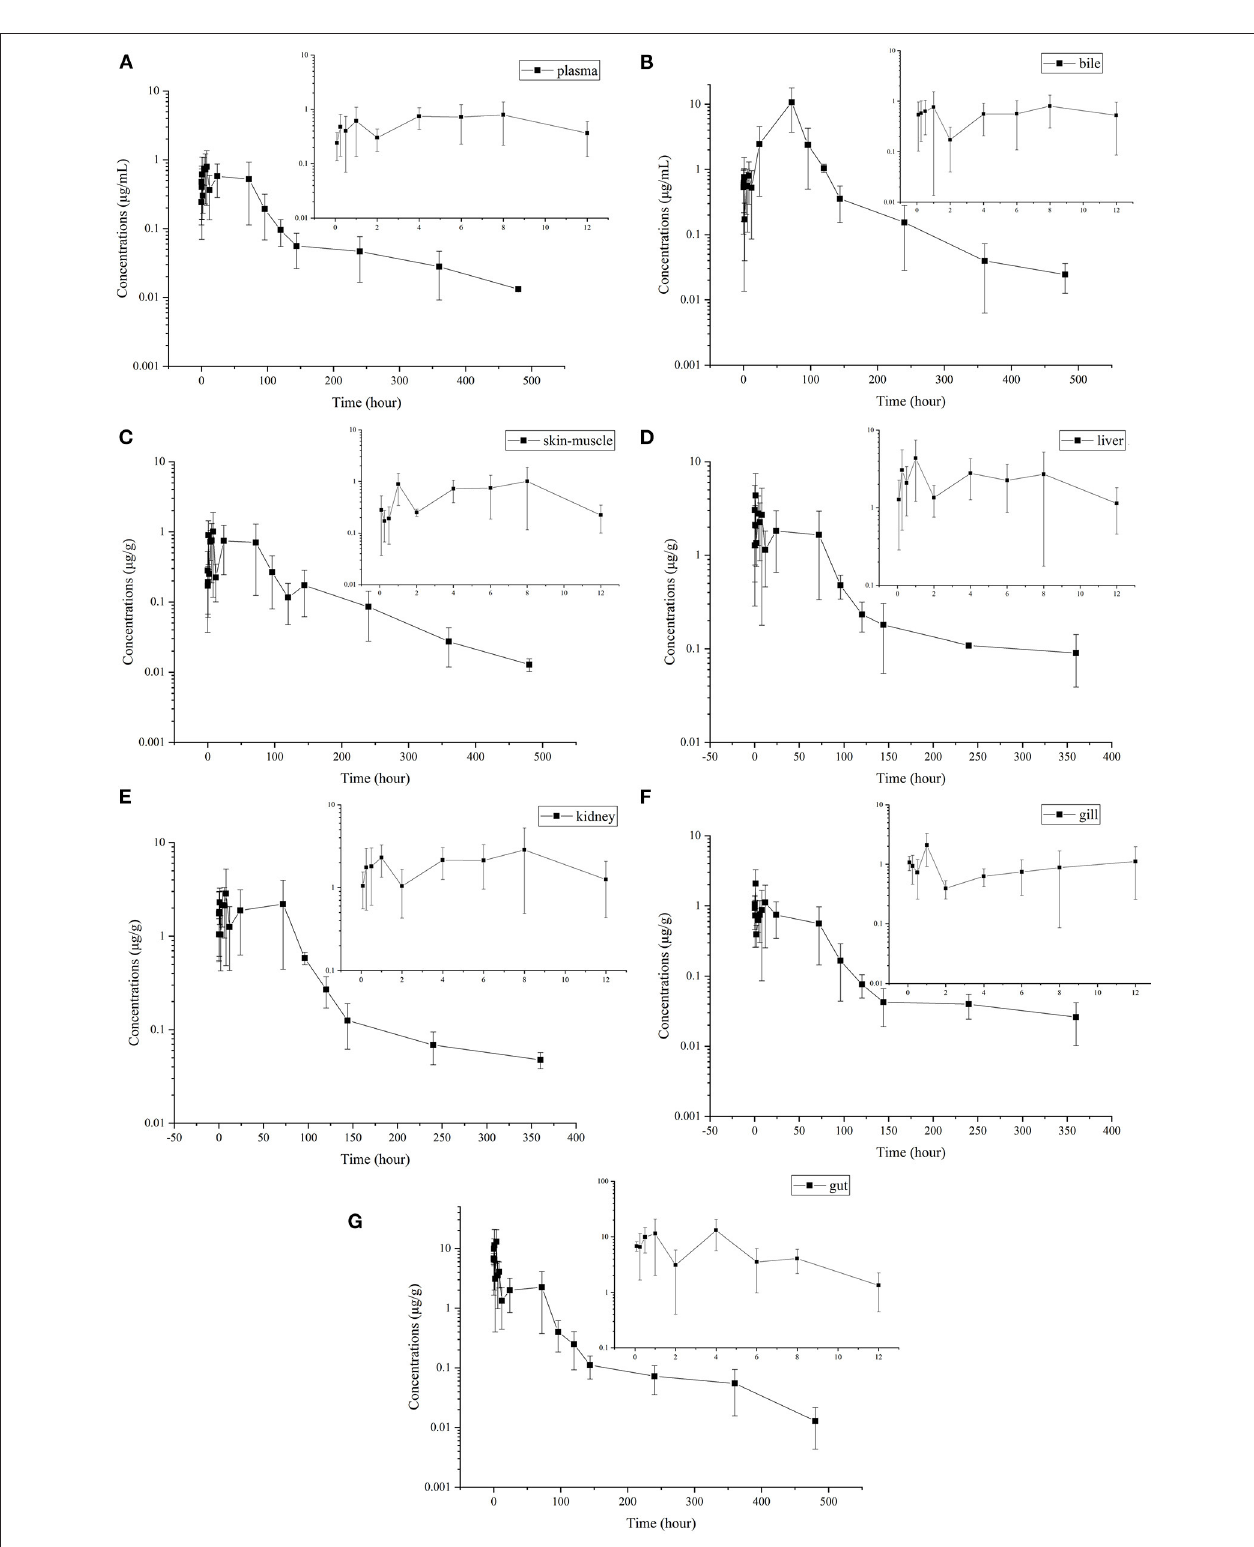
FIGURE 1 | Mean ( ± SD) concentrations ( µ g · mL − 1 or µ g · g − 1 ) of enrofloxacin following single oral administration of enrofloxacin at 10 mg/kg BW in Yellow River carp ( Cyprinus carpio haematoperus ) reared at 20 ◦ C [ (A) for plasma, (B) for bile, (C) for skin-on muscle, (D) for liver, (E) for kidney, (F) for gill, and (G) for gut]. All five samples at the last sampling point could be quantified in bile, gill, and gut. However, in plasma, kidney, skin-muscle, and liver, only 2, 2, 2, and 4 samples could be quantified at the last quantifiable time point, respectively (their concentrations were greater than the LOQ). Those samples below the LOQ were omitted and not used to calculate pharmacokinetic parameters and withdrawal